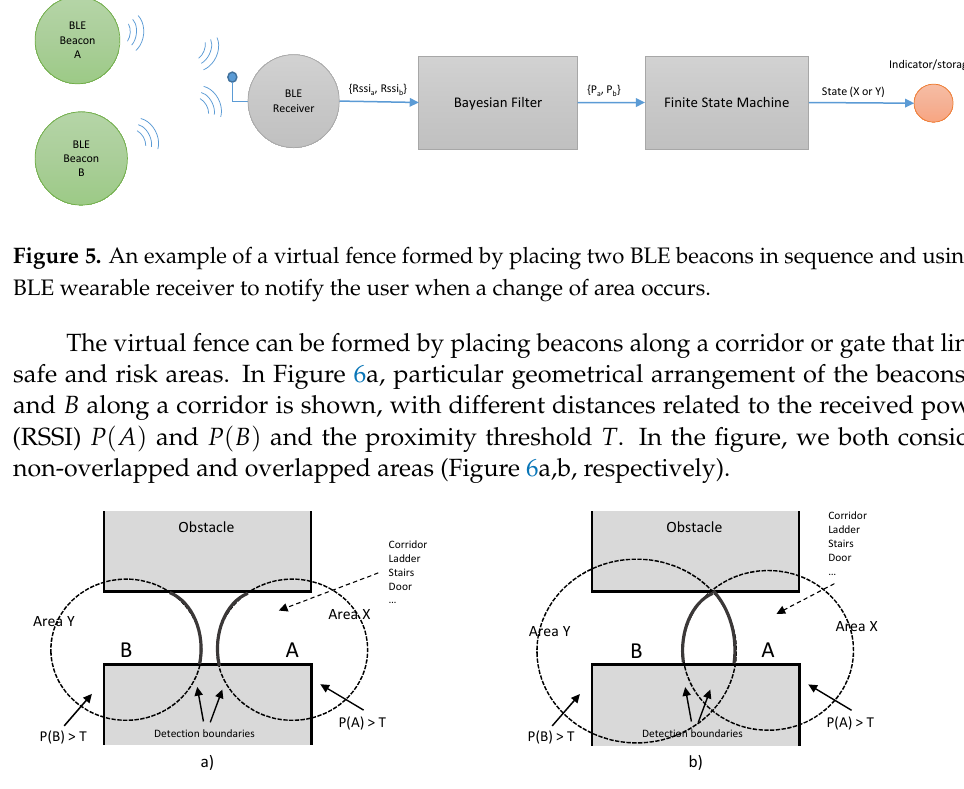
Figure 6. Beacons A and B define a virtual barrier in the transition between a safe place and a risk area. Proximity areas are defined by the proximity function. In ( a ), the proximity areas to A and B are separate. In ( b ), the two proximity areas overlap